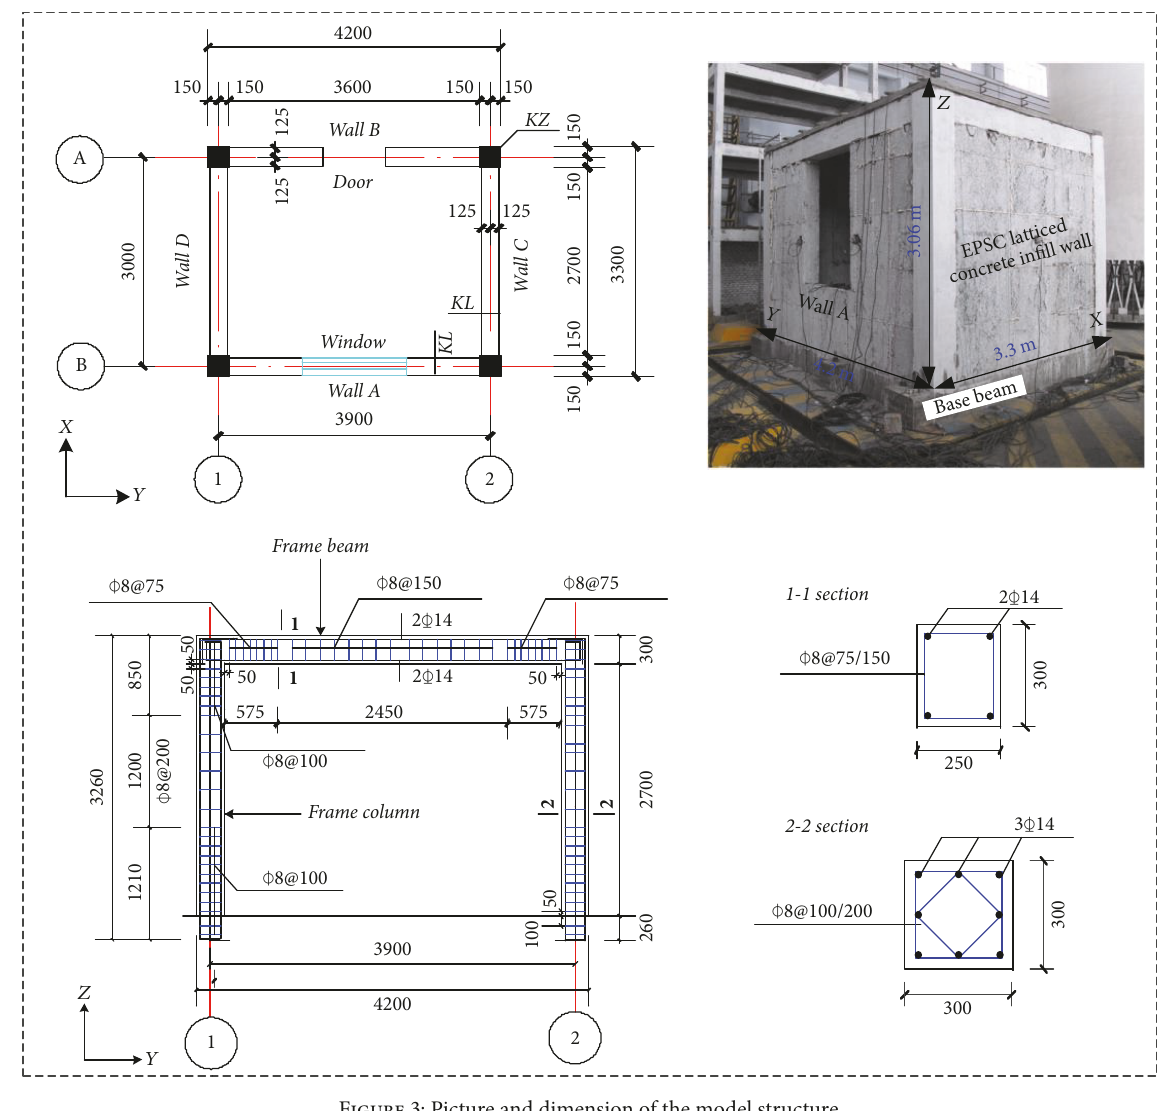
Figure 3: Picture and dimension of the model structure.